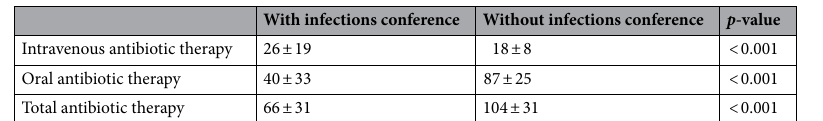
Table 4. Mean duration in days of intravenous, oral and total antibiotic therapy. Due to its prolonged therapy, M. tuberculosis spondylodiscitis is not respected in this analysis.